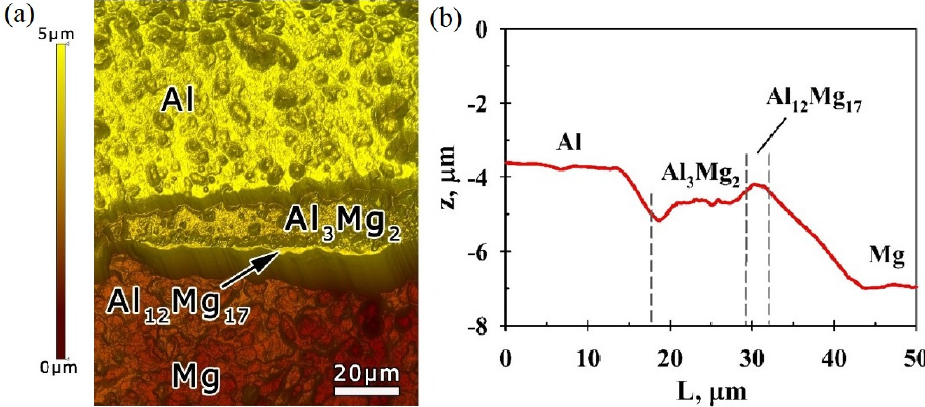
Figure 6. AFM image ( a ) and profile ( b ) of the Al-Mg composite surface after irradiation.